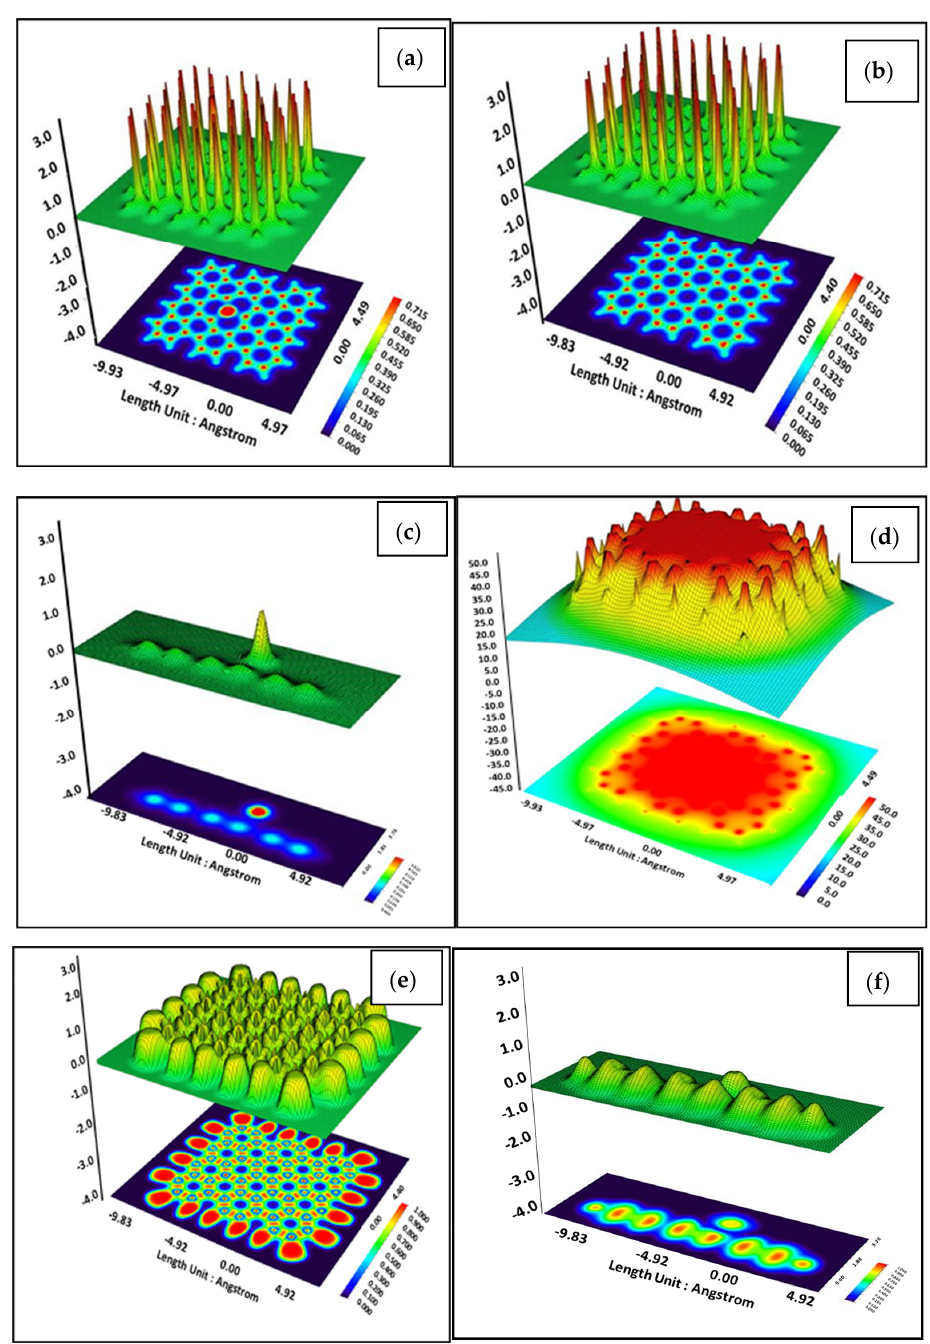
Figure 6. 2D and 3D Electron density contour plots of ( a ) Pd-doped graphene ( b , c ) Pd-decorated graphene and Electron localization function projections of ( d ) Pd-doped graphene ( e , f ) Pd-decorated graphene. The charge accumulation regions are in red, while the charge depletion regions are in blue.